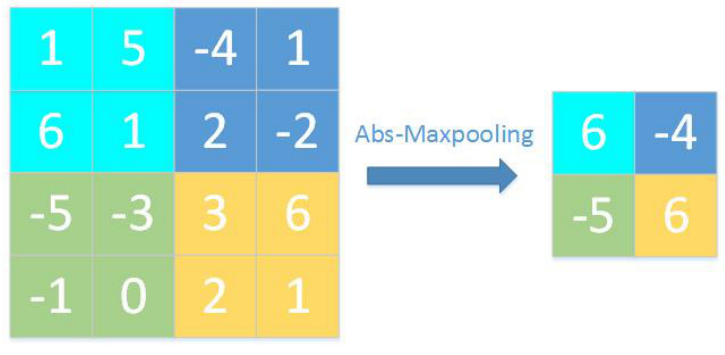
Figure 2. Abs-MaxPool. Figure 2.